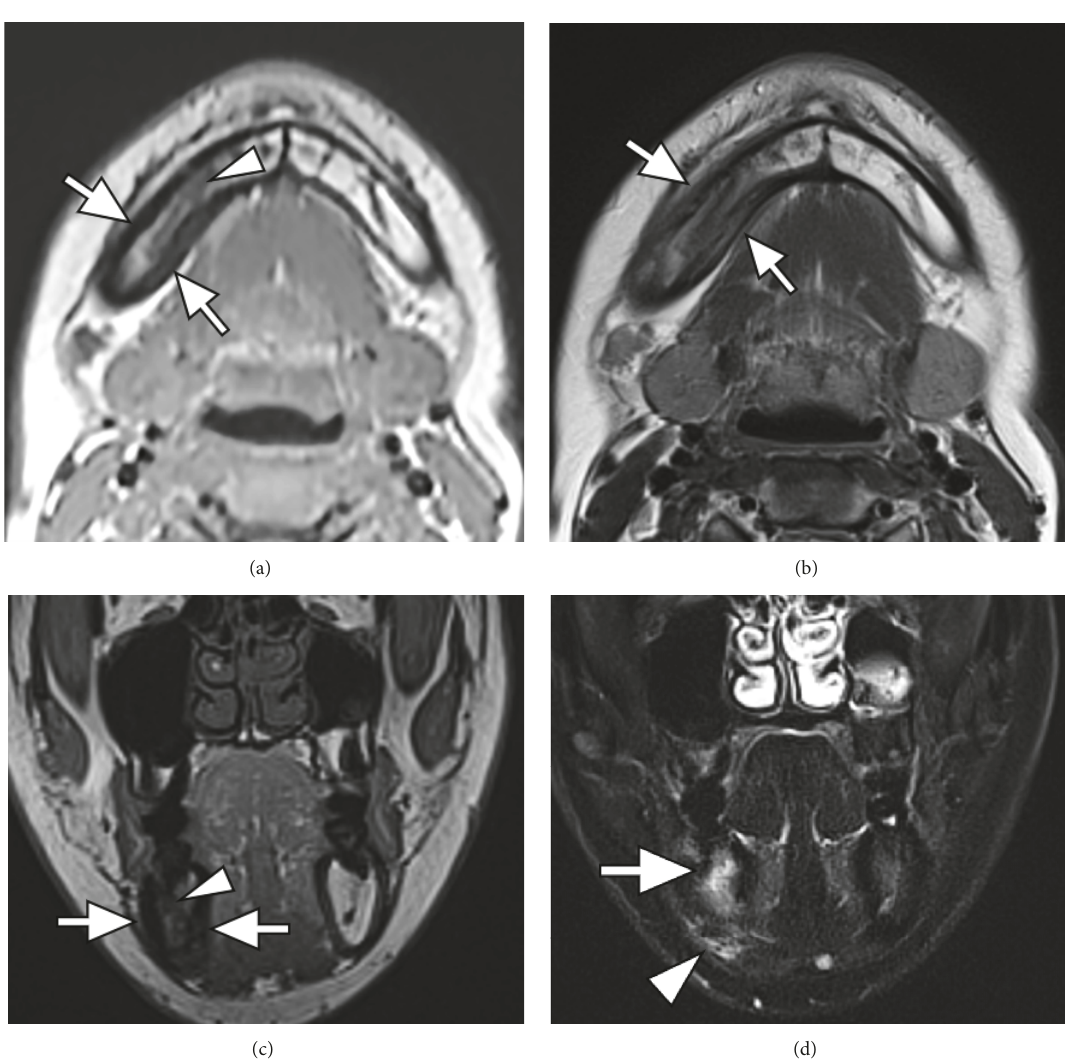
Figure 3: MR imaging of the mandible. Axial (a) and coronal (c) T1-weighted images and axial T2-weighted image (b) show thickening of the right mandible (arrows) and decreased bone marrow fat signal (arrowheads). Coronal short tau inversion recovery image (d) shows high signal intensity in the right body of the mandible (arrow), with perilesional soft tissue swelling